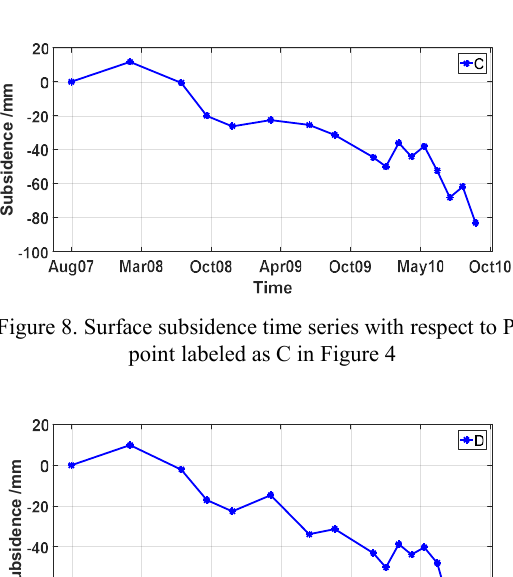
Figure 7. Surface subsidence time series with respect to PS point labeled as B in Figure 4